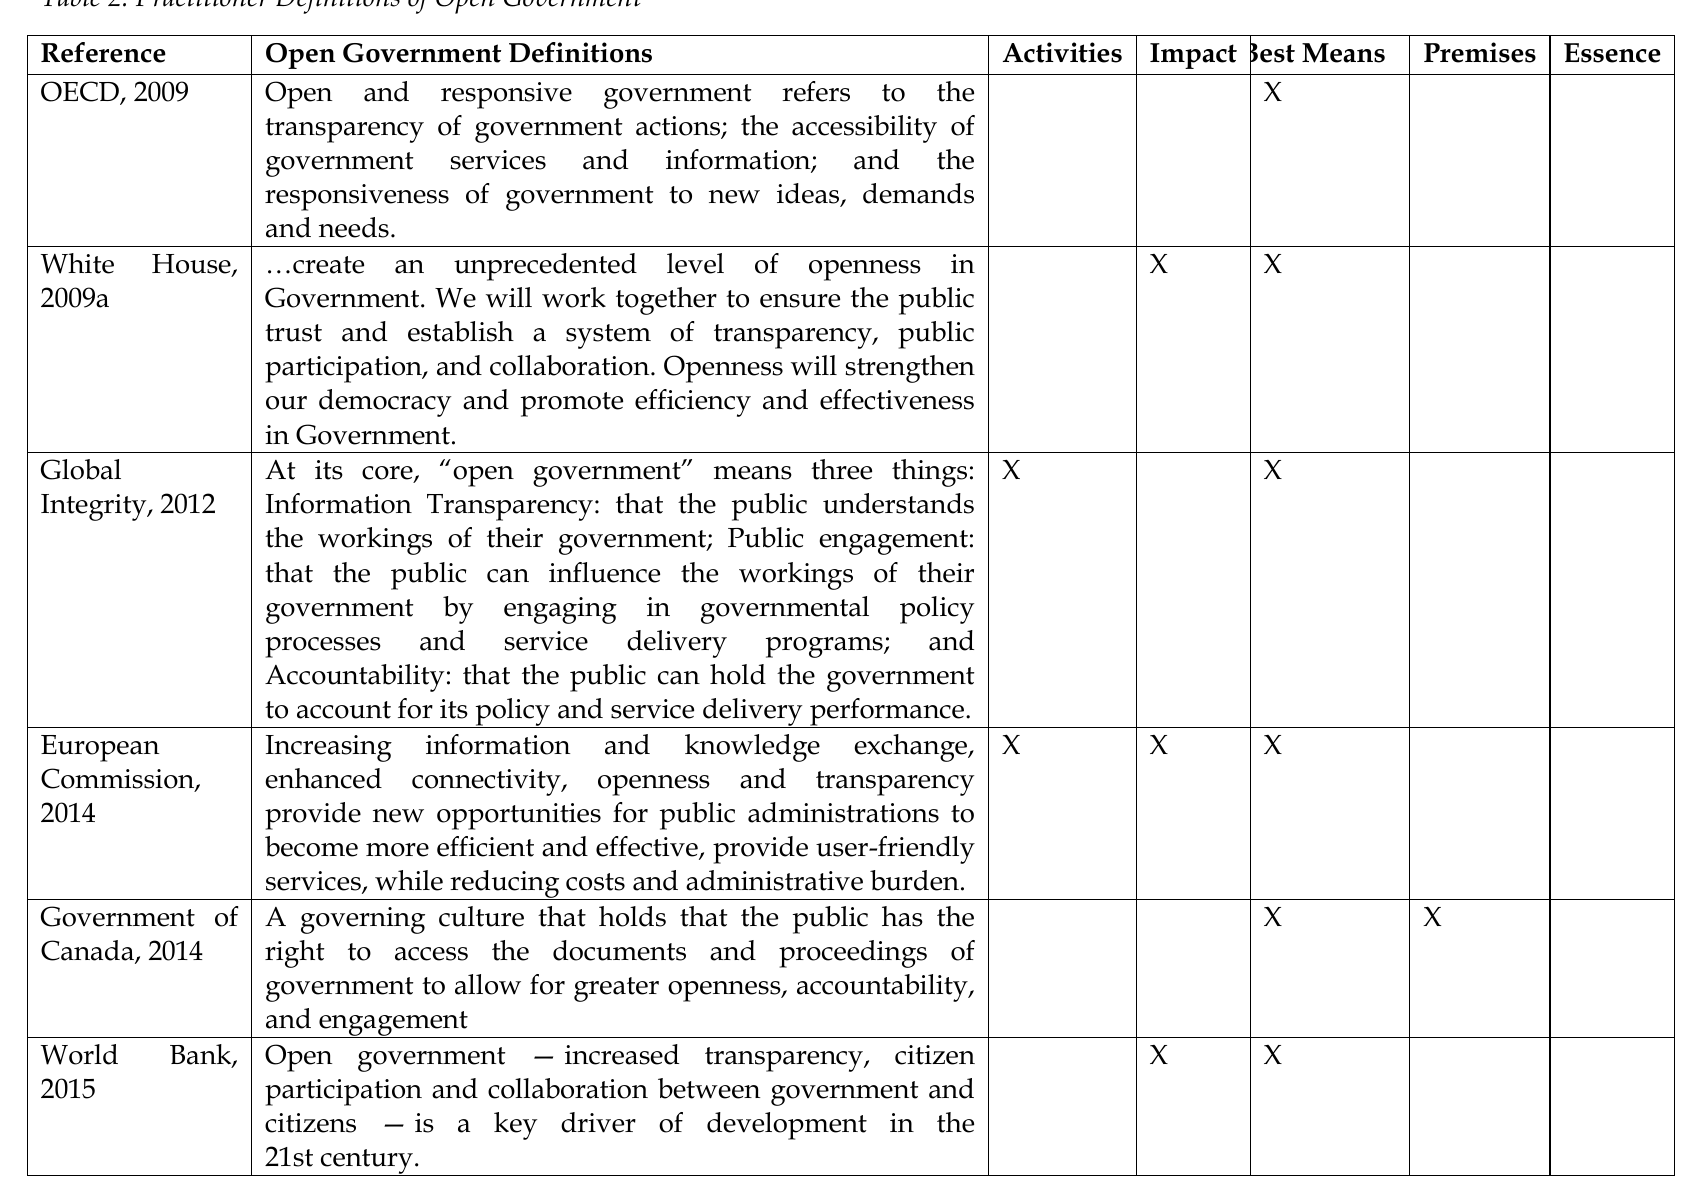
Table 2: Practitioner Definitions of Open Government